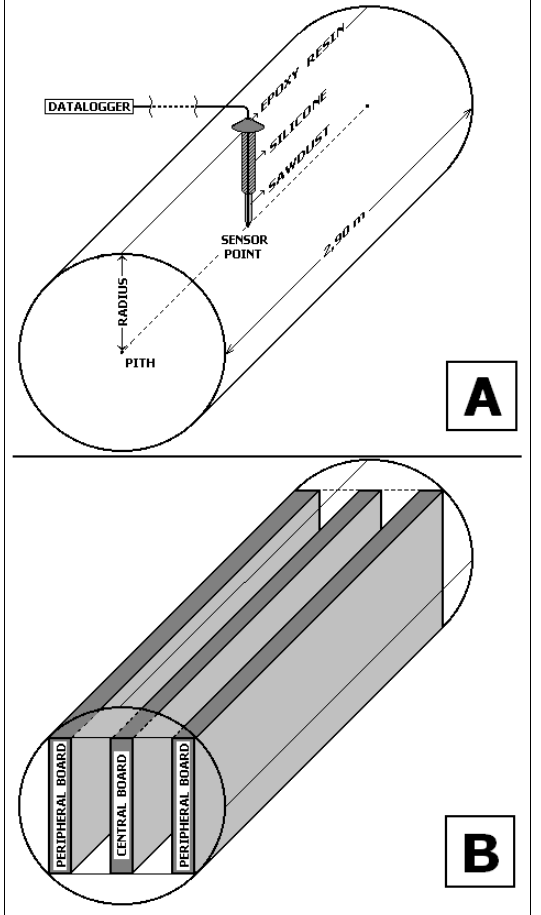
Fig. 1 – (A) Thermocouple out layers accommodation in the log; (B) peripheral and central positions of